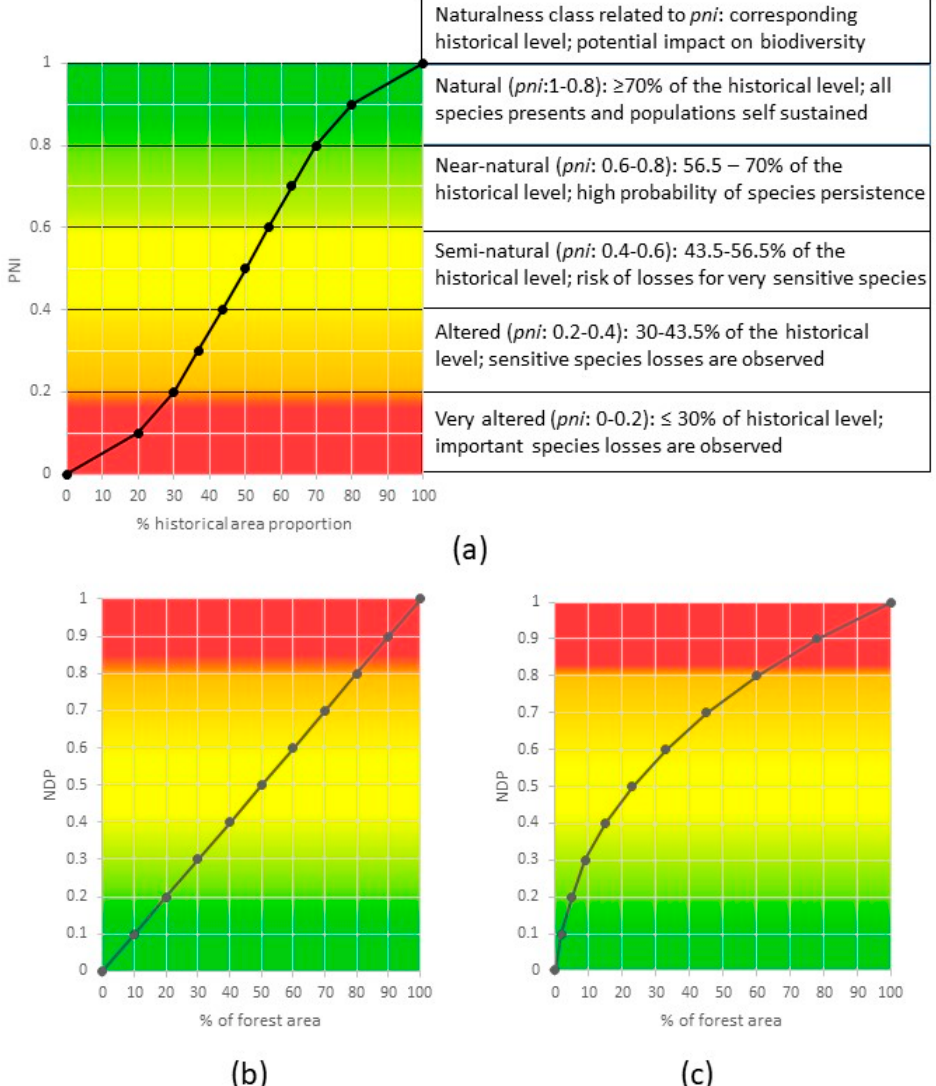
Figure 3. Generic curves used for modelling. ( a ) Sigmoid curve for the partial naturalness index of condition indicators. ( b ) Linear curve for naturalness degradation potential evaluation for pressure indicators proportional to the area. ( c ) Logarithmic curve for naturalness degradation potential evaluation for high potential impact pressure indicators. Table 2. Characteristic_PNI equations for each naturalness characteristic.